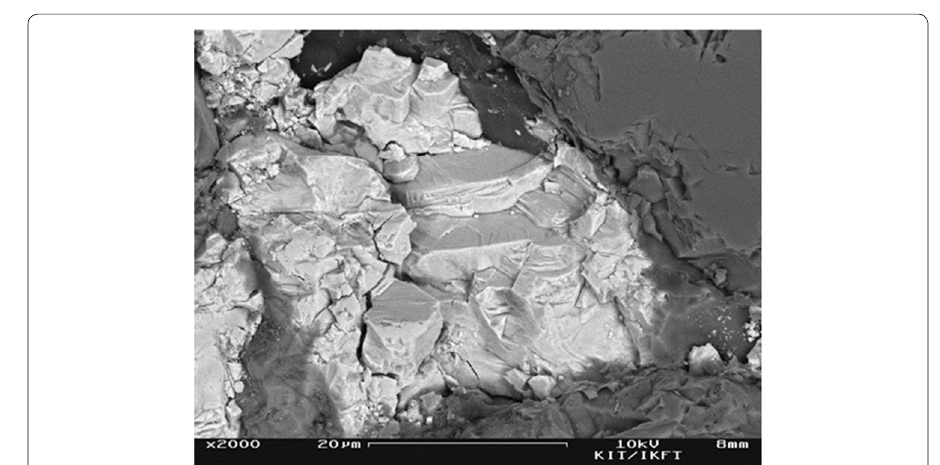
Fig. 15 Crystal agglomeration of barite, sample 7.2 (PV07; 60 °C/20 bar)